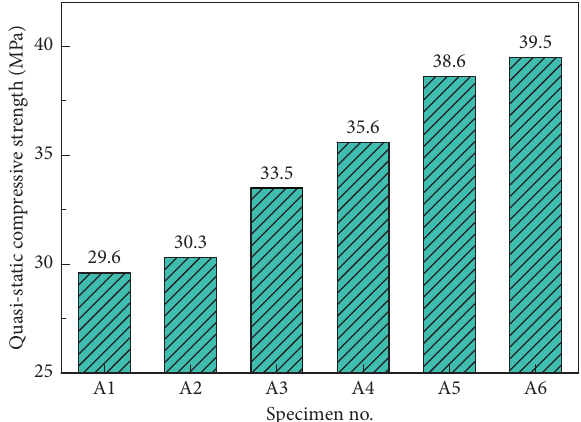
Figure 4: Static compressive strength of HPFRC.